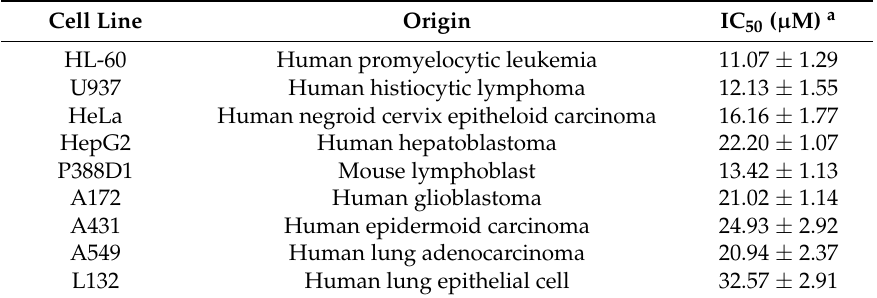
Table1. Effect of 23-HUA on cell growth against various cancer cell lines. Table 1. Effect of 23-HUA on cell growth against various cancer cell lines.